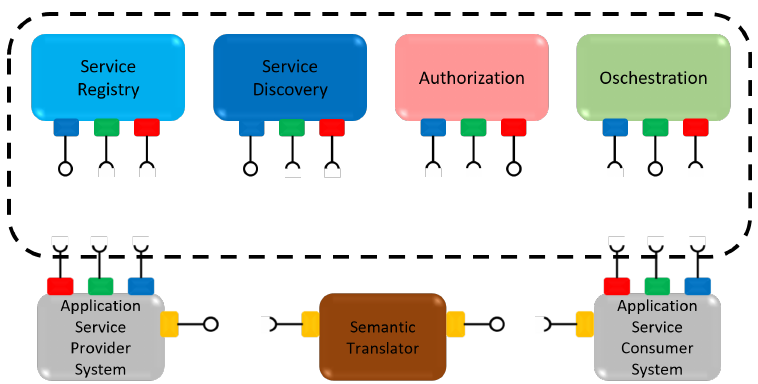
Figure 2. A translator supporting the interaction between heterogeneous applications services.